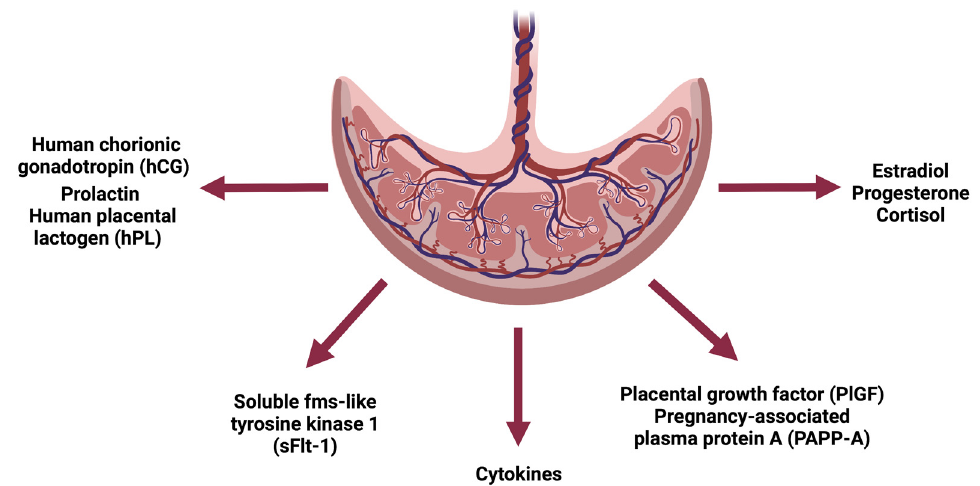
Figure 1. Schematic representation of the endocrine function of the placenta. Created with BioRender.com (accessed on 17 December 2022).